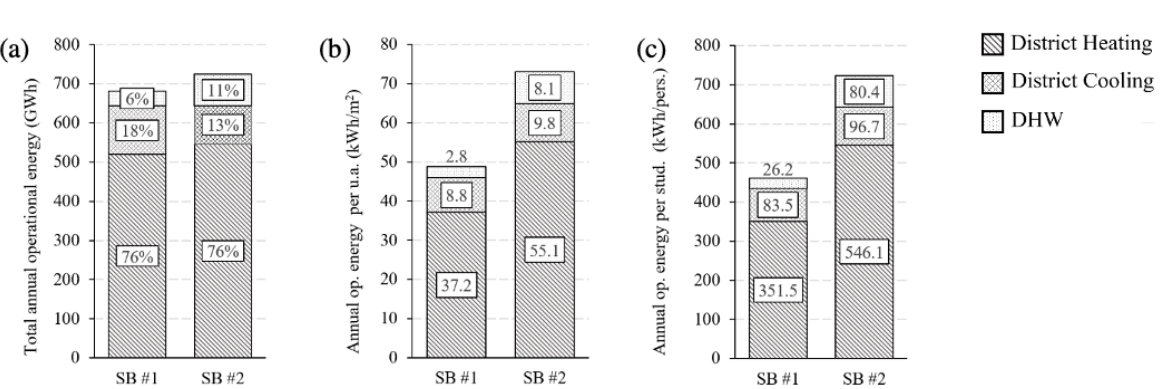
Figure 3. Comparison of operational energy of buildings grouped by districts: (a) total amount; (b) amount per unit of gross building area; (c) amount per person.